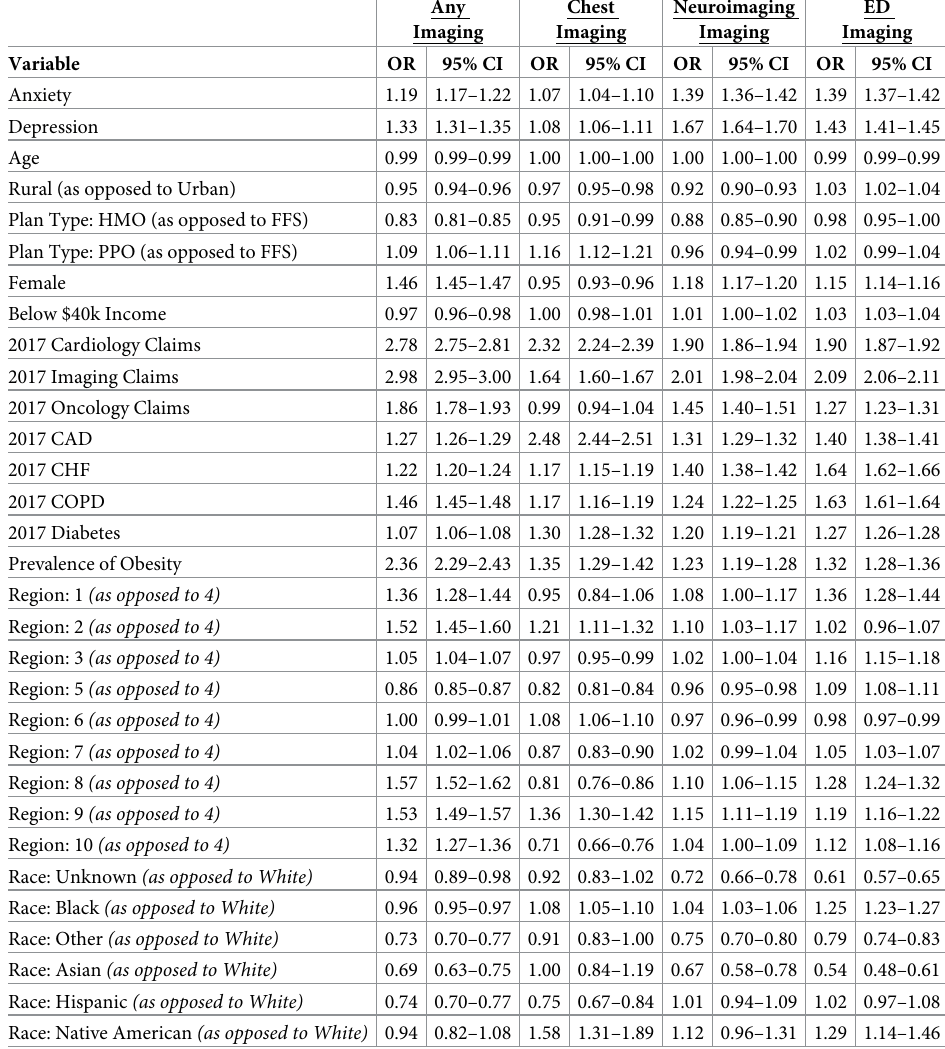
Table 6. Adjusted odds ratios for factors, including race, influencing use of any imaging by patients with Medi- care advantage health plans (sample after matching).